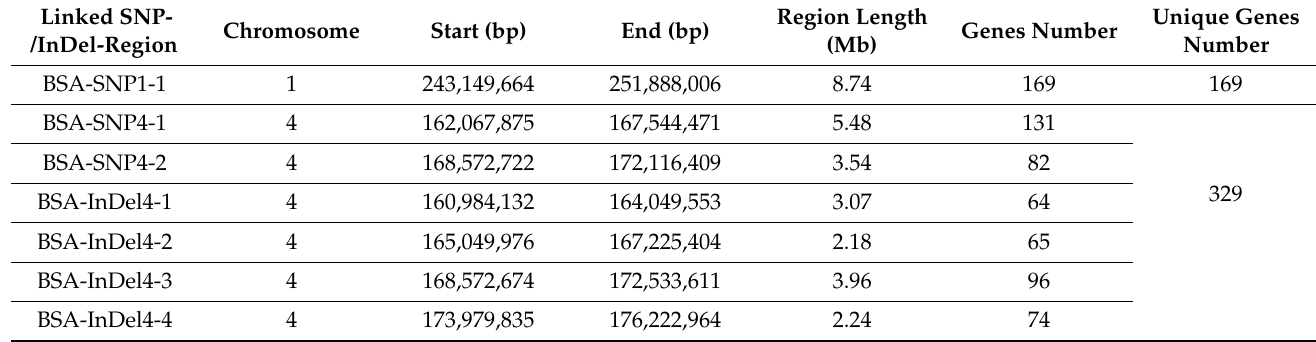
Table 2. Mapping candidate SNP-region and InDel-region information based on BSA strategy of mesocotyl length (MES) under 20 cm sowing